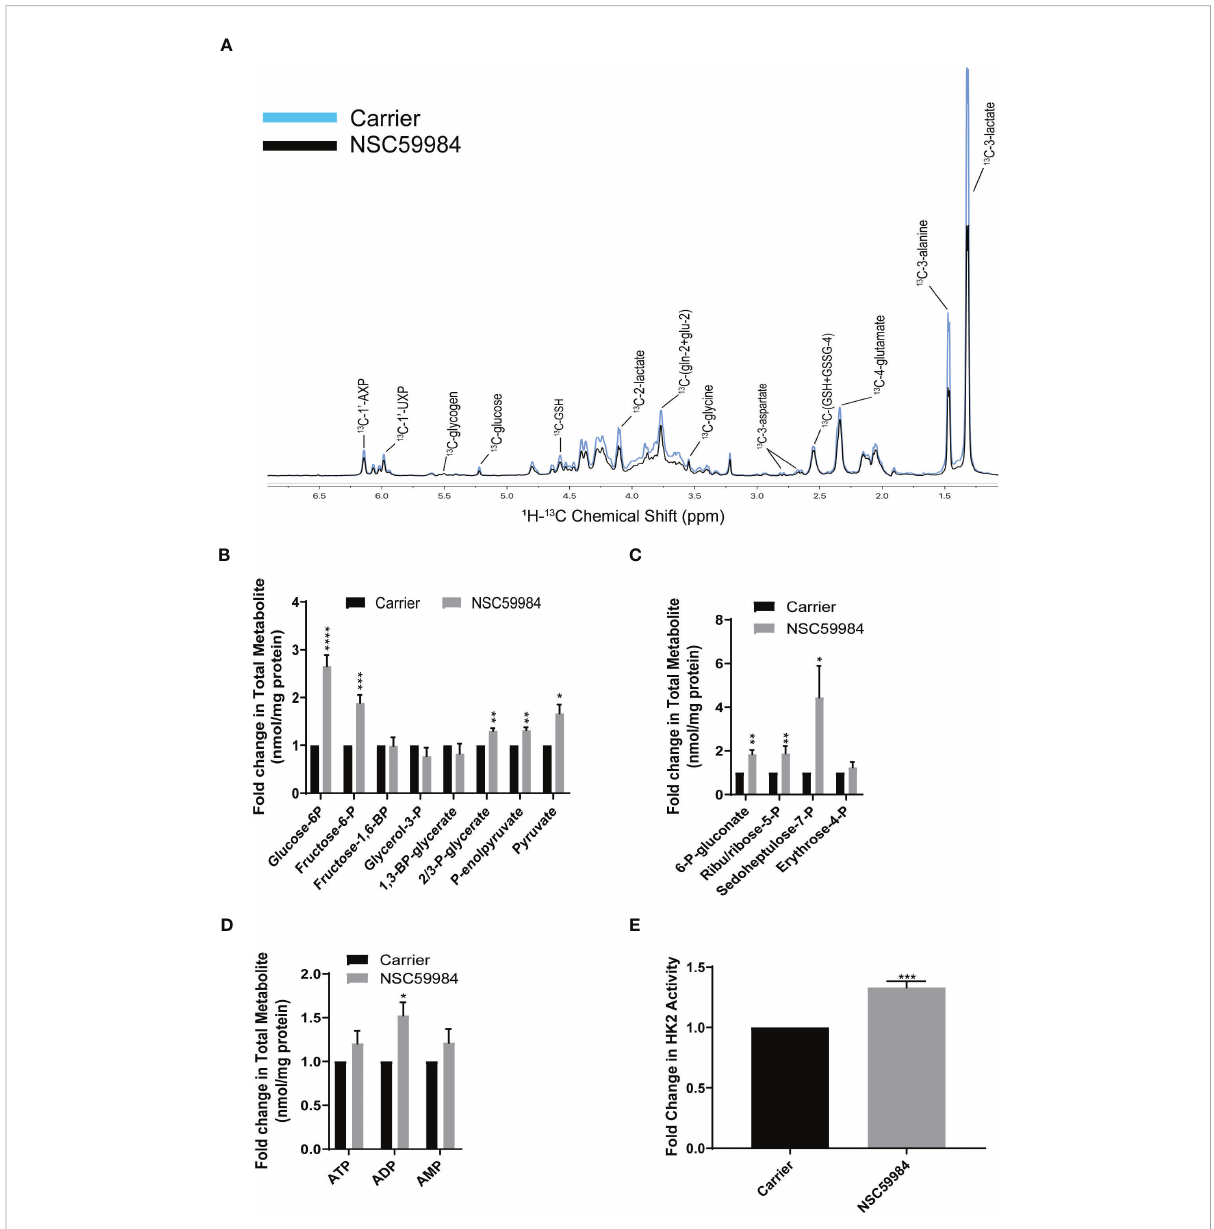
FIGURE 6 NSC59984 treatment results in activation of the PPP. (A) Incorporation of [ 13 C 6 ] glucose into cellular metabolites of ESO26-R248W cells following treatment with NSC59984 (12 m M) for 72 hr was assessed by 1 H- 13 C HSQC NMR. Spectra were normalized to total cellular protein content. B-D: Fold change in total cellular quantities of metabolite intermediates were assessed by IC-FTMS over carrier control set to 1 in: (B) Glycolysis pathway; (C) Pentose phosphate pathway; (D) Adenylates ATP, AMP, and ADP. (E) Fold change in Hexokinase activity following treatment with NSC59984 (12 m M) for 72 hr over carrier control in ESO26-R248W cells. Fold change in carrier-treated cells was normalized to 1. A-E. Paired t-tests were carried out for statistical analysis for each of these assays. * = 0.05, ** = 0.005, *** = 0.0005, **** =